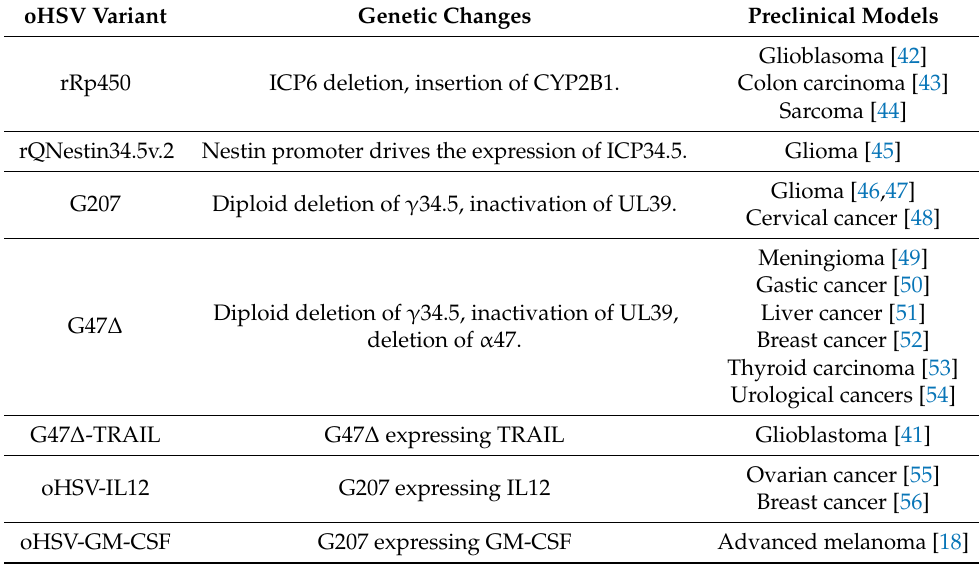
G47 ∆ -TRAIL G47 ∆ expressing TRAIL oHSV-IL12